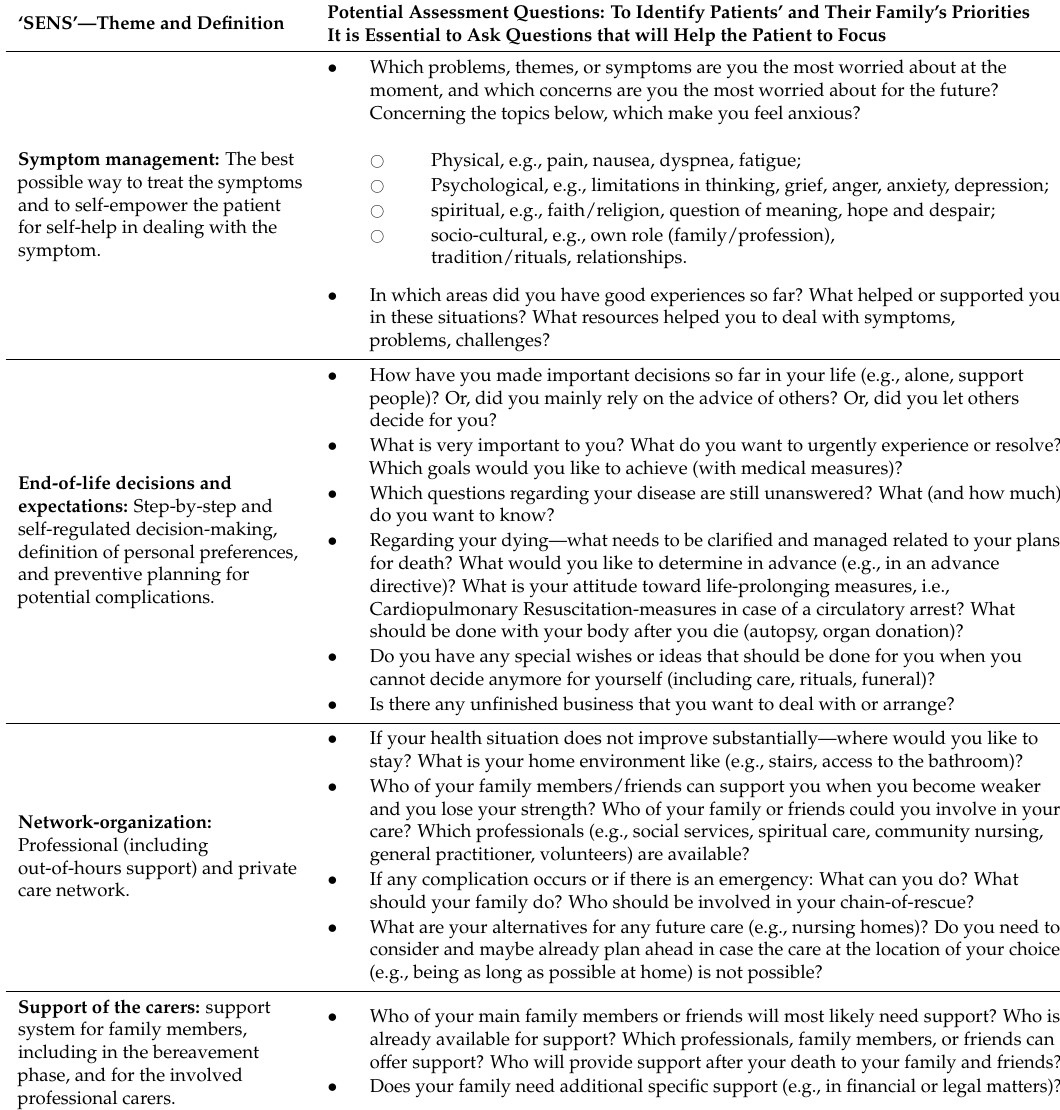
Table 2. Patient prompt sheet: ‘SENS’-structure with themes and potential assessment questions. ‘SENS’—Theme and